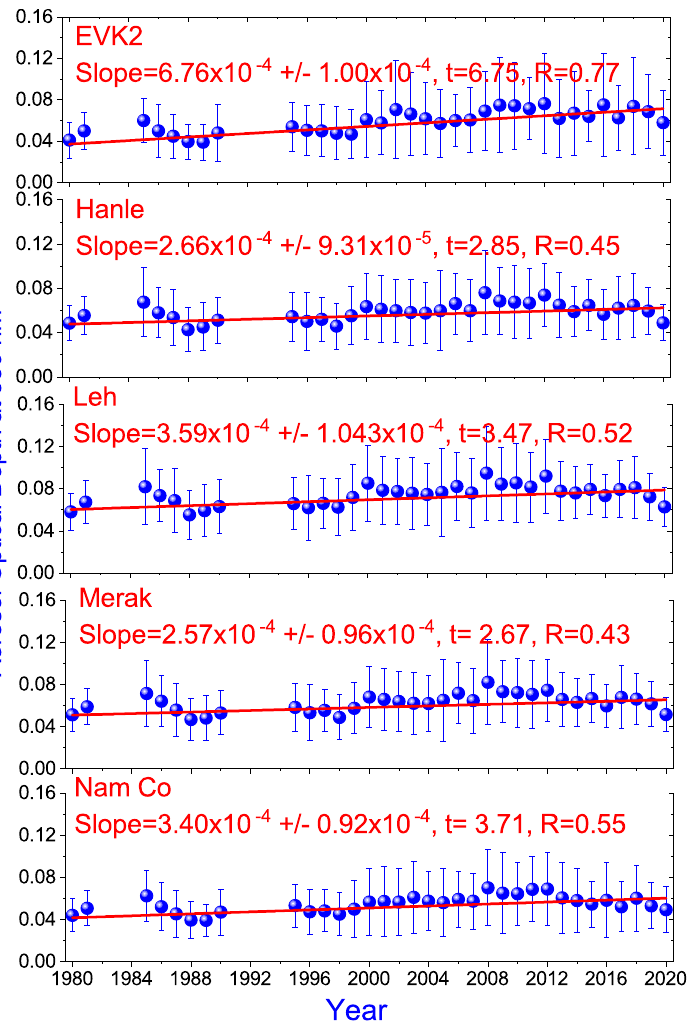
Figure 4. Yearly AOD trend at selected sites (background sites) in the HKH region using monthly MERRA-2 data in